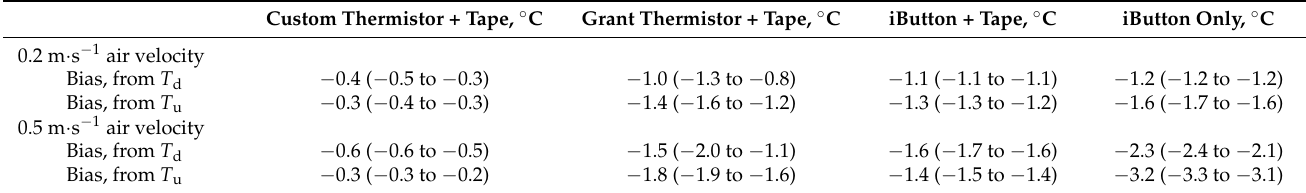
Table 1. Calculated estimates of bias (mean (95% confidence intervals)) for a fixed surface skin temperature sensor of 31 ◦ C, expressed as difference from the disturbed reference temperature ( T d ) and from the corresponding undisturbed reference temperature ( T u ). Negative values for bias indicate the skin temperature sensor is cooler than the corresponding reference